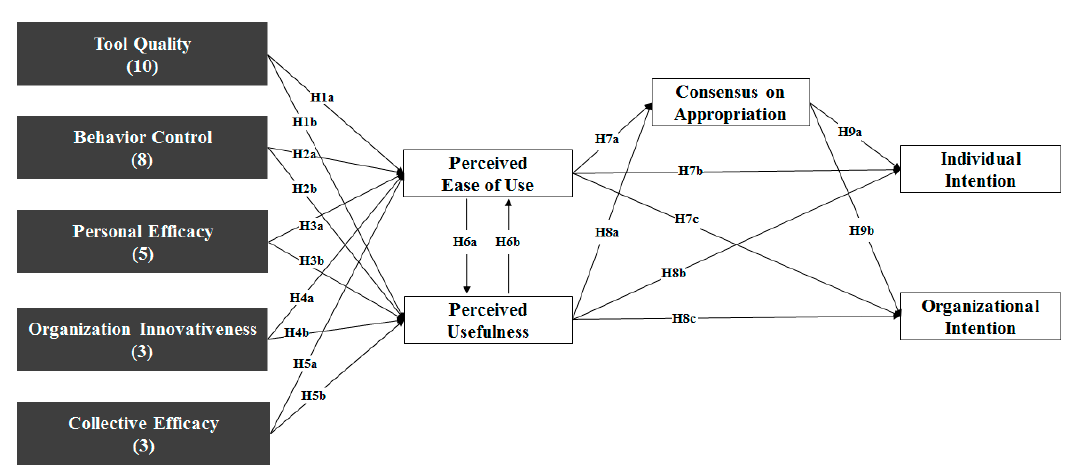
Figure 3. Proposed model for the mobile BIM acceptance model.